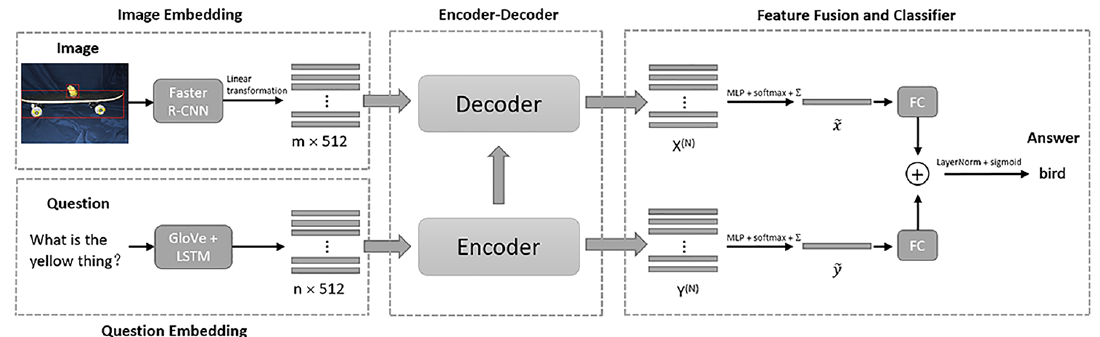
Figure 1. The overall architecture of Multi-modal Explicit Sparse Attention Networks